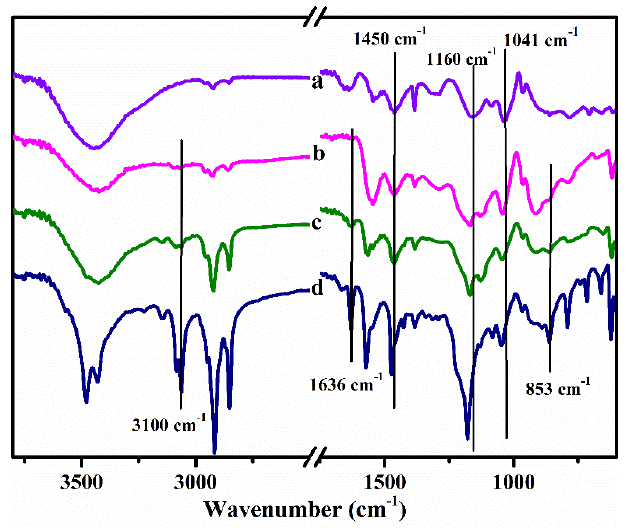
Figure 1. FTIR spectra of samples prepared in ( a ) water, ( b ) [C 2 mim]Br, ( c ) [C 6 mim]Br and ( d